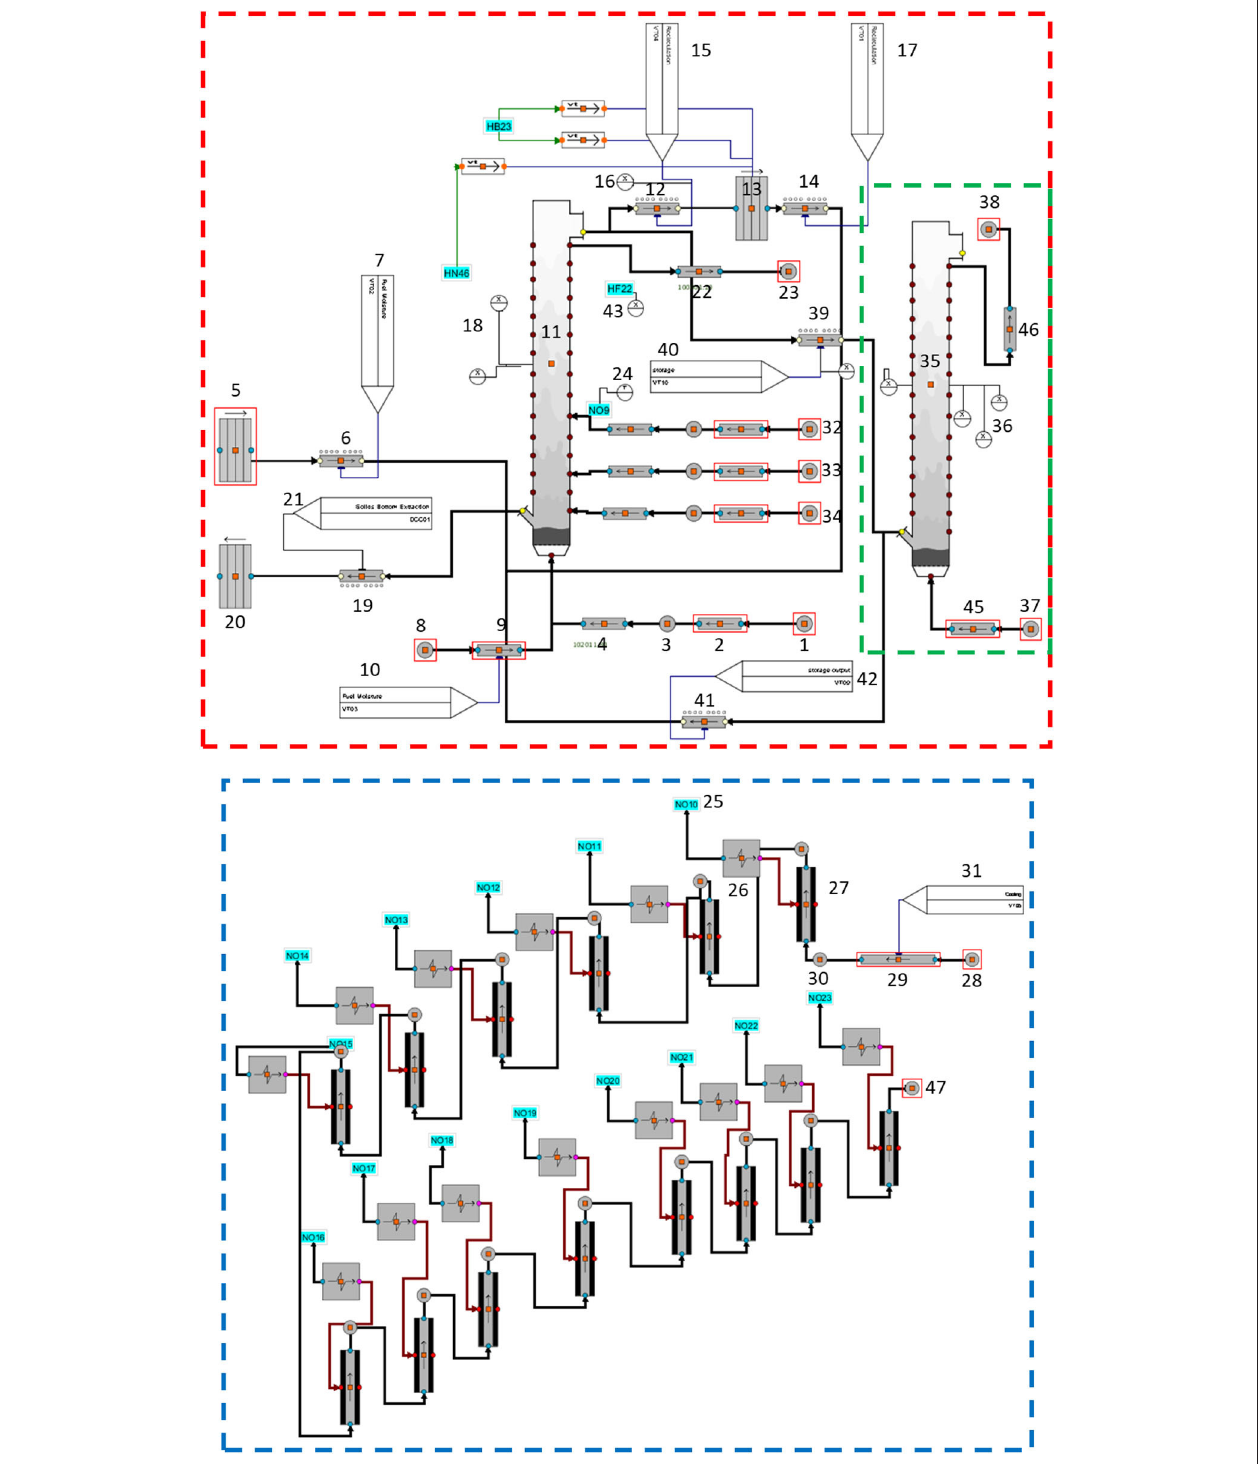
FIGURE 3 | Process diagram of the circulating fluidized bed system (the red colored line highlights the gas/solids side, the blue line highlights the water cycle, while the green line highlights the TES process).